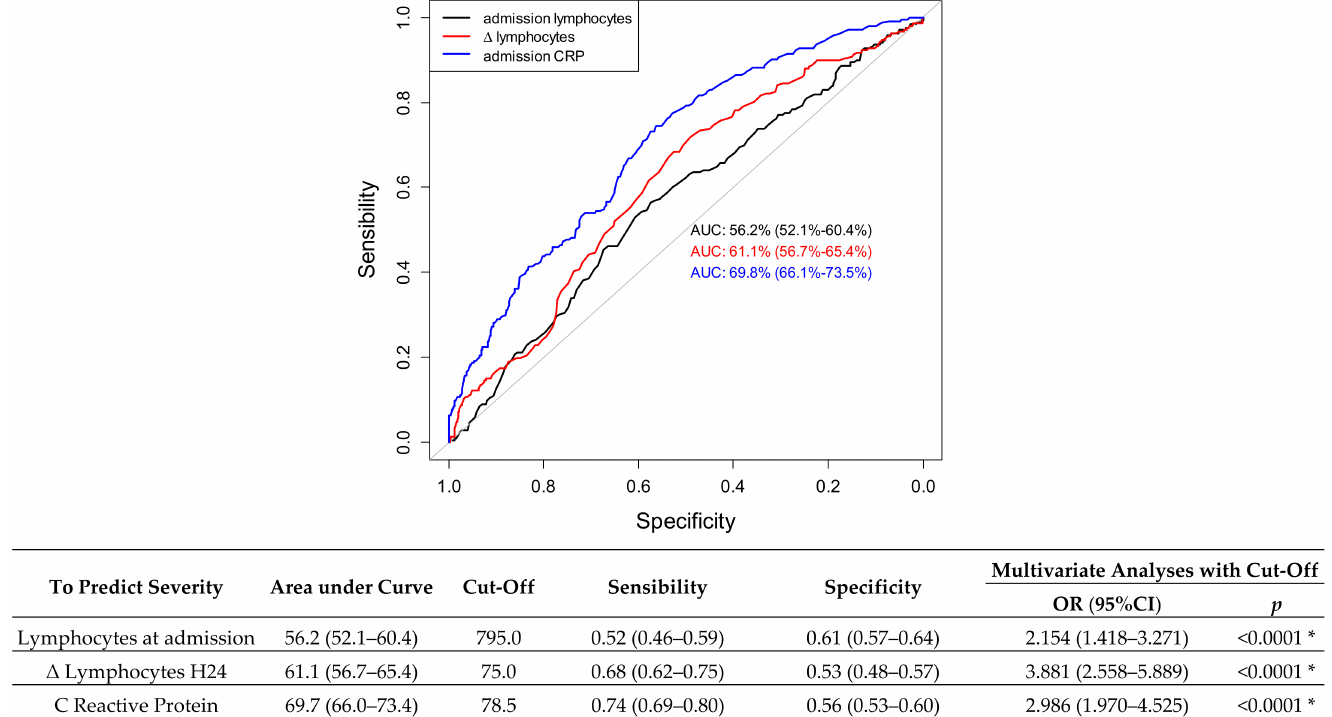
Figure 1. Receiver operating characteristics curve (ROC) for the ability of lymphocyte and early version to predict severity. Legend: CRP = C reactive protein, * = p < 0.005.